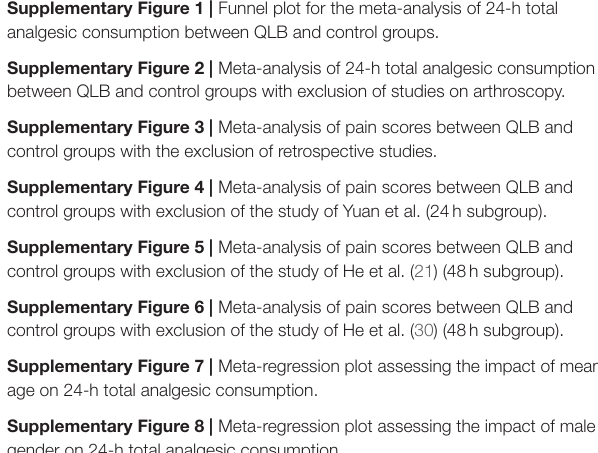
Supplementary Figure 9 | Meta-regression plot assessing the impact of sample size on 24-h total analgesic consumption. Supplementary Figure 10 | Meta-regression plot assessing the impact of QLB type on 24-h total analgesic consumption. Supplementary Figure 11 | Meta-regression plot assessing the impact of local anesthetic type on 24-h total analgesic consumption. Supplementary Figure 12 | Meta-regression plot assessing the impact of mean age on 12h pain scores. Supplementary Figure 13 | Meta-regression plot assessing the impact of male gender on 12h pain scores. Supplementary Figure 14 | Meta-regression plot assessing the impact of sample size on 12h pain scores. Supplementary Figure 15 | Meta-regression plot assessing the impact of QLB type on 12h pain scores. Supplementary Figure 16 | Meta-regression plot assessing the impact of local anesthetic on 12h pain scores. Supplementary Figure 17 | Meta-regression plot assessing the impact of mean age on 24h pain scores. Supplementary Figure 18 | Meta-regression plot assessing the impact of male gender on 24h pain scores. Supplementary Figure 19 | Meta-regression plot assessing the impact of sample size on 24h pain scores. Supplementary Figure 20 | Meta-regression plot assessing the impact of QLB type on 24h pain scores. Supplementary Figure 21 | Meta-regression plot assessing the impact of local anesthetic on 24h pain scores. Supplementary Table 1 | PRISMA checklist. Supplementary Table 2 | Search strategy. Supplementary Table 3 | GRADE assessment of evidence. Supplementary Table 4 | Meta-regression analysis for the heterogeneity of post-operative 24h total analgesic consumption. Supplementary Table 5 | Meta-regression analysis for the heterogeneity of 12h pain scores. Supplementary Table 6 | Meta-regression analysis for the heterogeneity of 24h pain